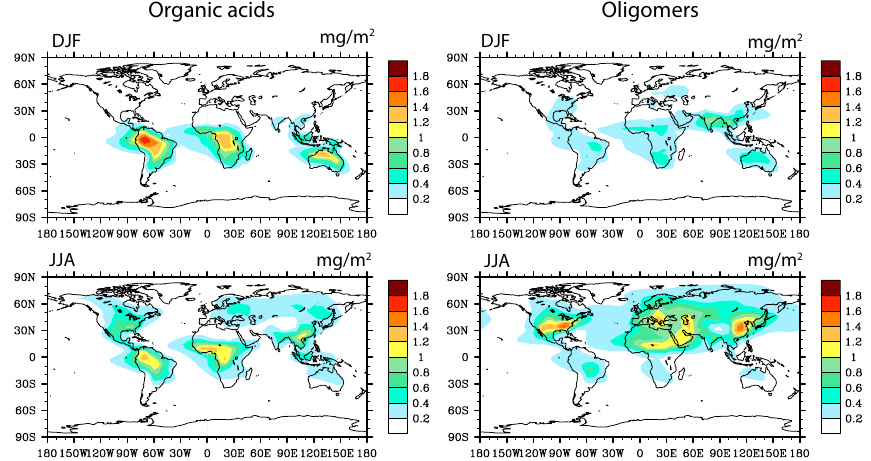
Figure 3. Seasonally averaged column concentrations (mg/m 2 ) of organic acids (left column) and oligomers (right column) in December, January and February (DJF) (top row) and in June, July and August (JJA) (bottom row). All plots are for Case 1.